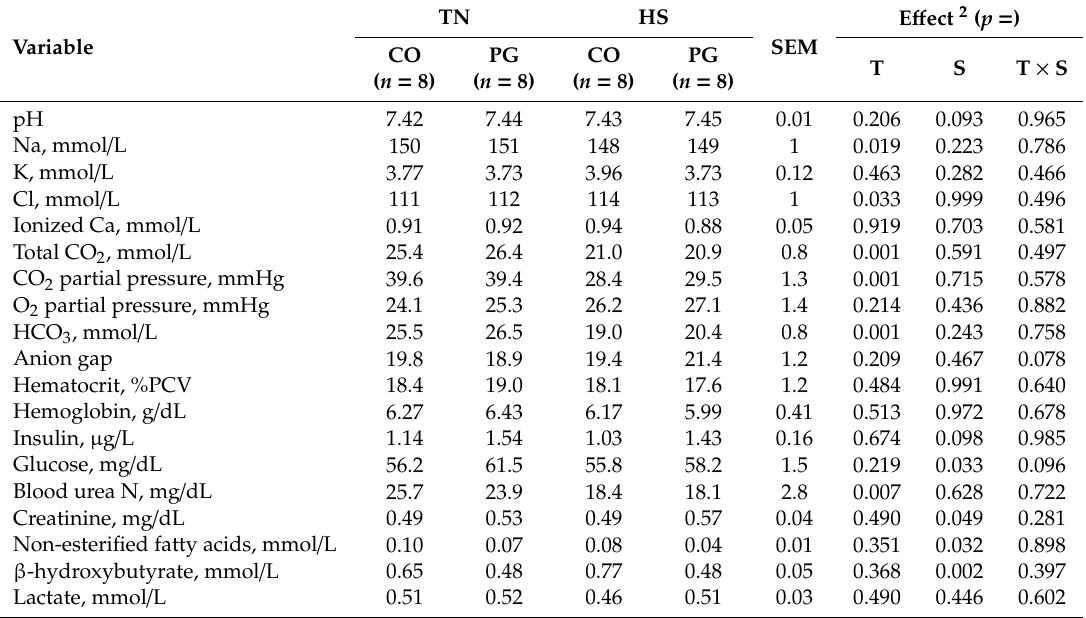
Table 3. Least squares means for blood metabolites in dairy goats under thermoneutral (TN) and heat stress (HS) conditions. In each ambient temperature, goats were fed a control diet (CO) or supplemented with propylene glycol (PG).